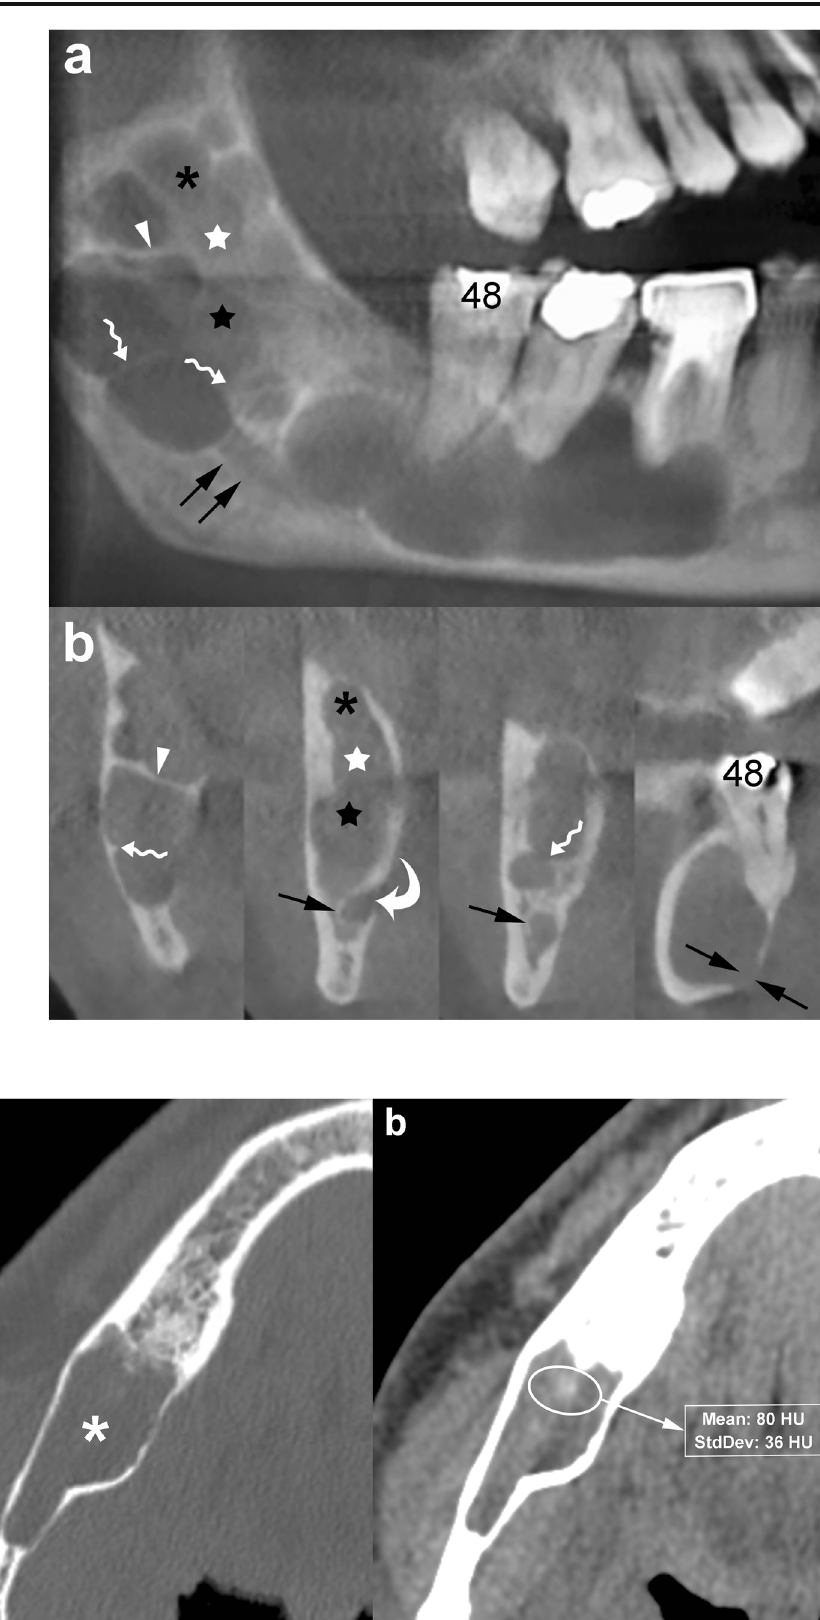
Fig. 11 Panoramic CBCT image with 20-mm slice thickness ( a ) shows a multilocular OKC. On this reconstruction, septa seem to divide the lesion into multiple loculations. Cross-sectional CBCT images reconstructed as 0.5-mm-thick sections ( b ) demonstrate that some of these septa are complete ( arrowheads ) and some are incomplete ( wavy arrows ). Note that certain small loculations shown by the panoramic CBCT image ( black asterisk , white and black stars ) actually correspond to a single large loculation with scalloped borders. Compression and lingual displacement of the mandibular canal, deep to the root of the third molar ( 48 ), is also shown ( opposing arrows ). Curved arrow , mandibular foramen; arrows , mandibular canal